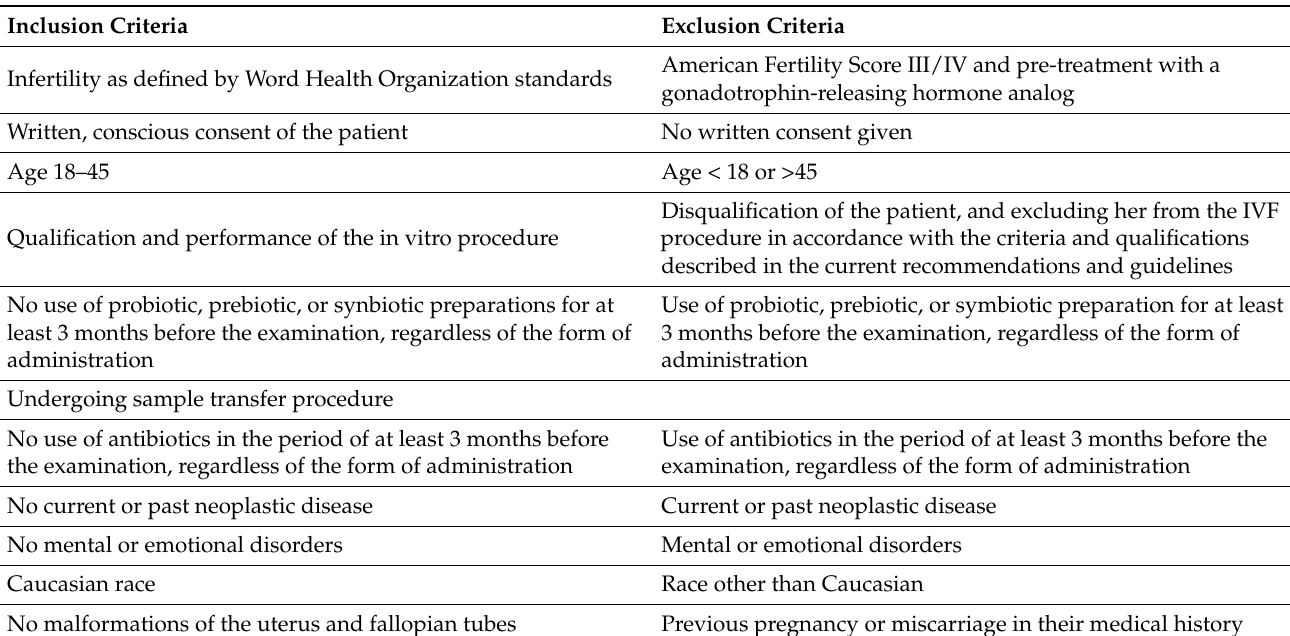
Table 2. Inclusion and exclusion criteria for the